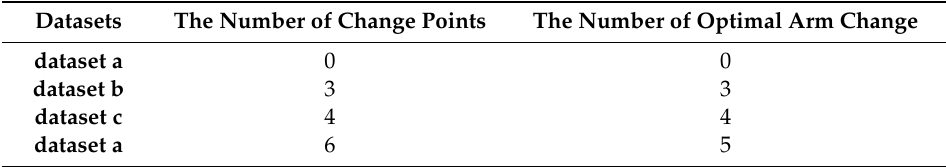
Figure 4. Datasets for different scenario. Y-label represents the average reward of each arm. ( a ) describes dataset a. ( b ) describes dataset b. ( c ) describes dataset c. ( d ) describes dataset d. Table 3. The characteristics of